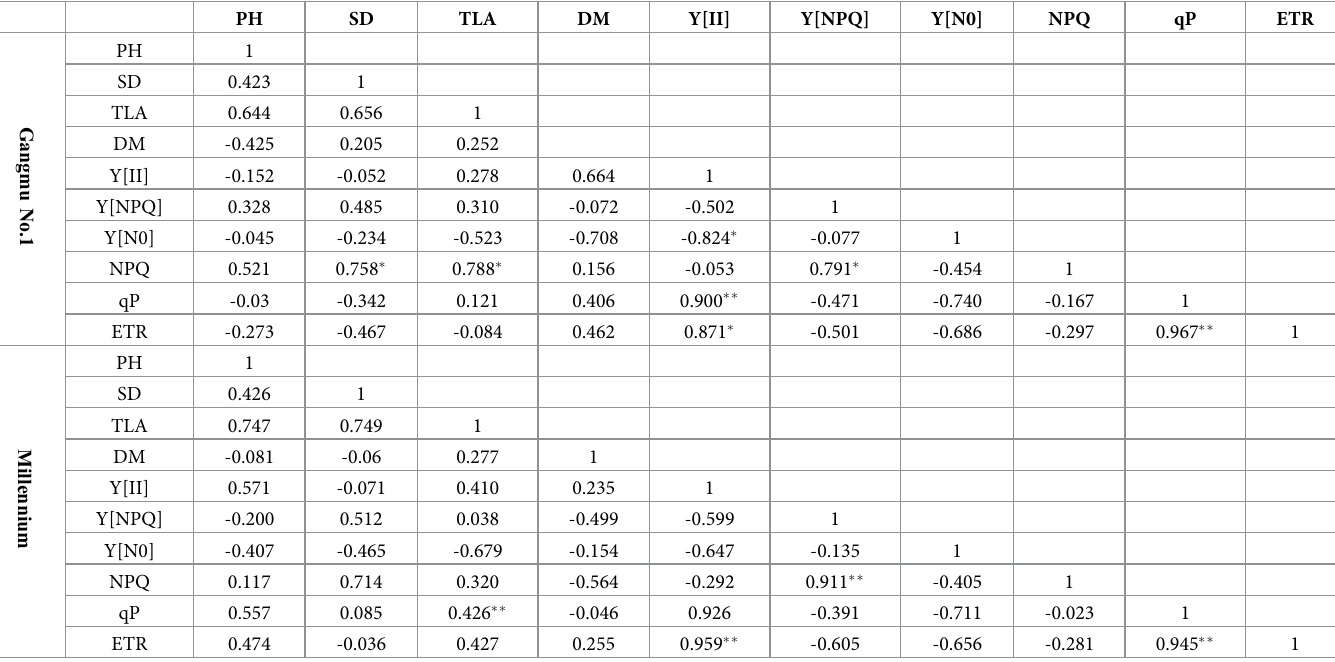
Table 2. Correlation coefficient evaluation between morphological and physiological parameters.